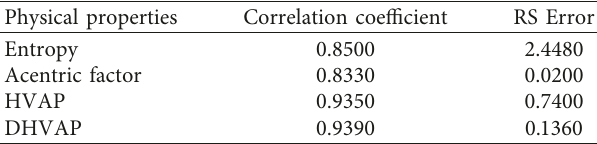
Table 5: NHGI and parameters of regression models.